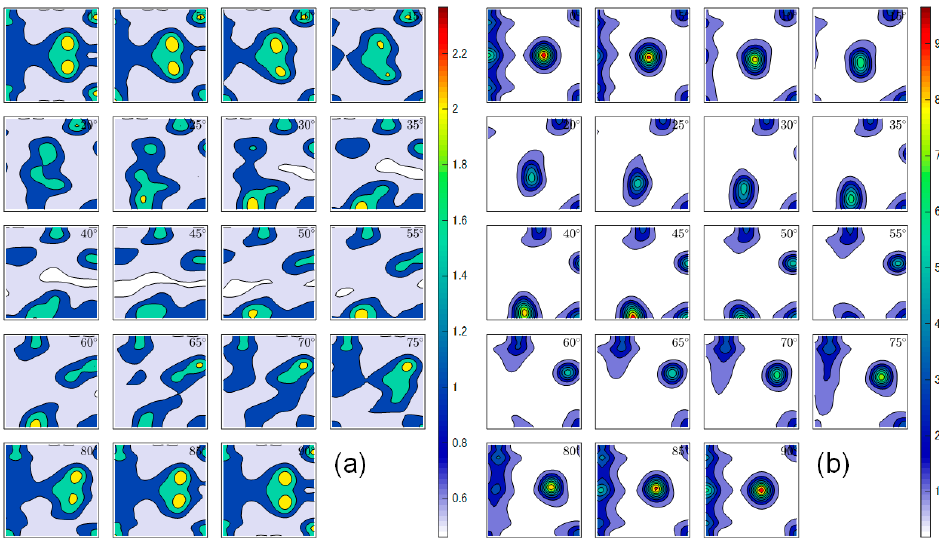
Figure 4. φ 2 sections of the orientation distribution function (ODF) of γ austenite at ( a ) E = 0 and ( b ) E = 0.42. The increment of φ 2 was 5°.